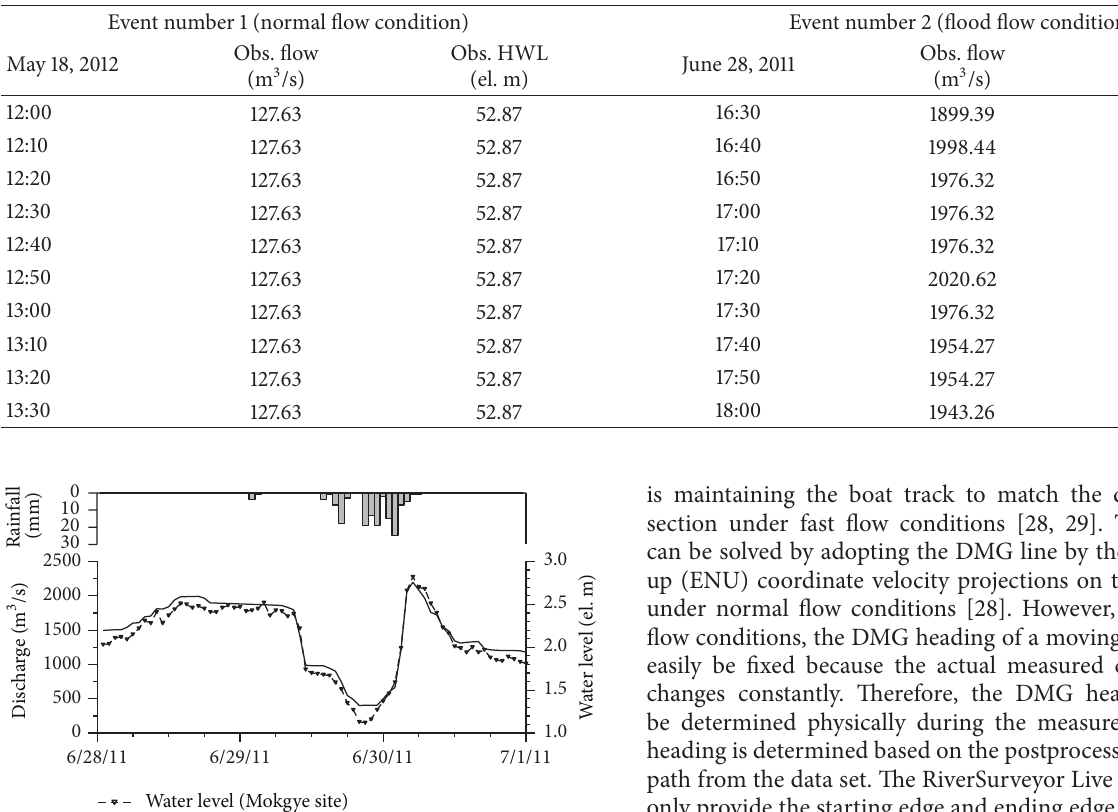
Table 3: Time series of hydrologic events used in this study.